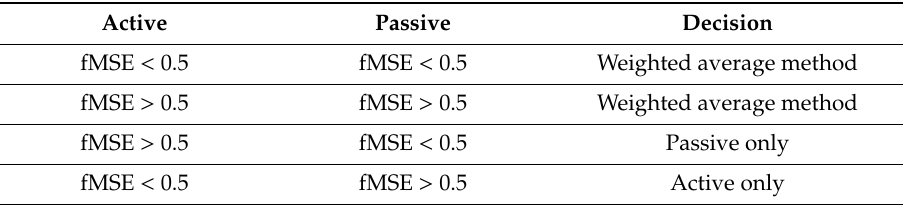
Table 2. The di ff erent cases for using fMSE threshold to maintain high-quality SM retrieval data. Note that, the threshold value was chosen at fMSE equal to